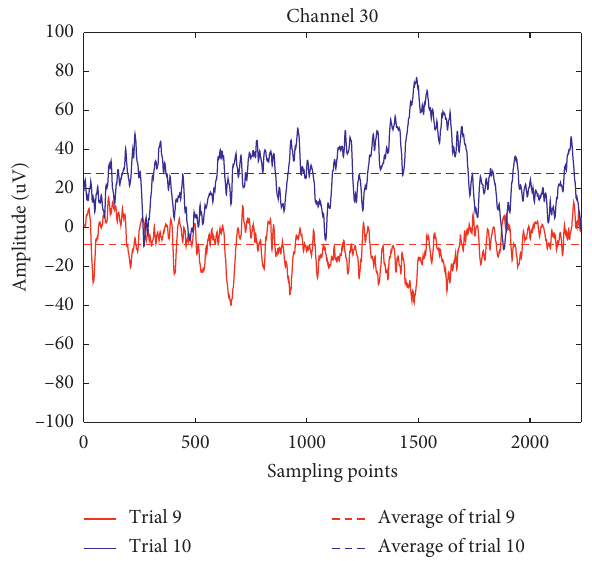
Figure 4: Trial 9 and 10’s amplitude of channel 30 in training